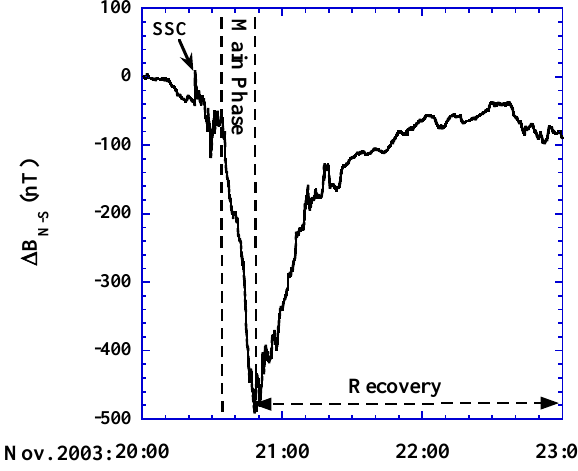
Figure 1. Compilation of north–south magnetic perturbations ( ∆ B N − S ) in nano-Tesla as observed between 20 and 23 November 2003 at six low-latitude stations during a very large magnetic storm. Times of the SSC (near mid-day on 20 November), the main and recovery phases are indicated for reference (Iyemori, 1990).